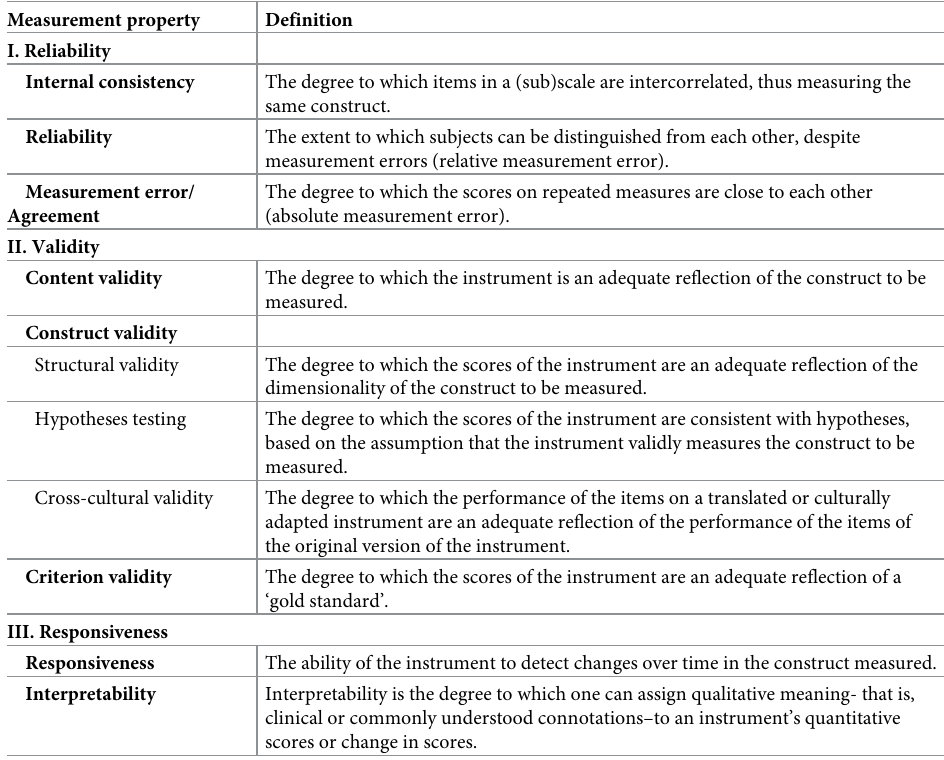
Table 2. Definition of measurement properties based on COSMIN [20] and Terwee et al.[21].